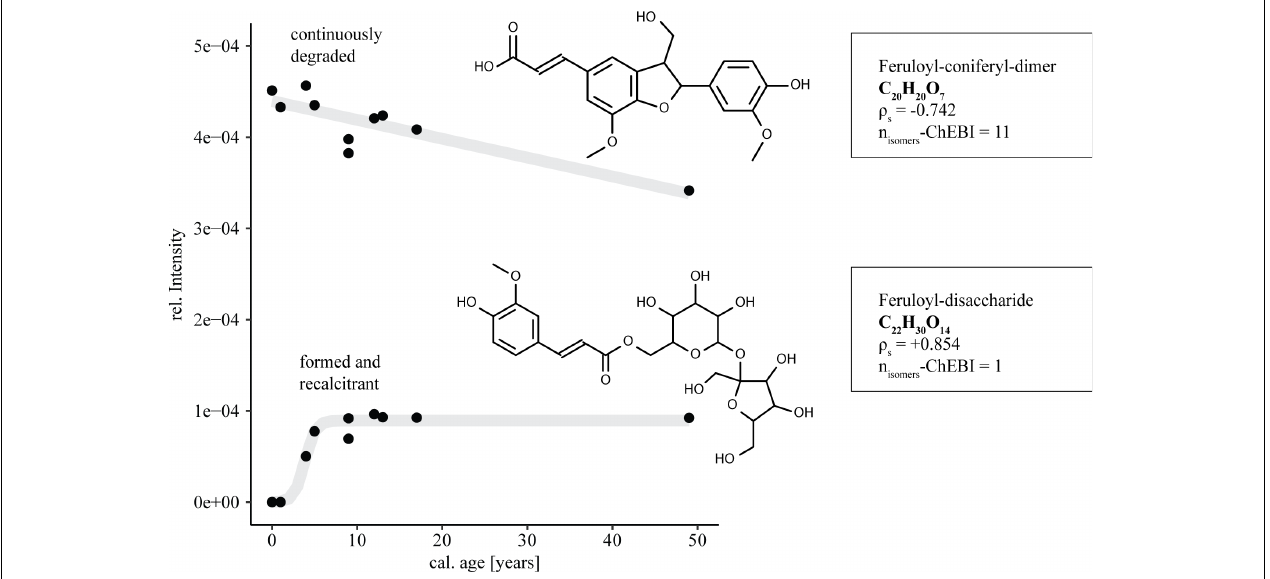
FIGURE 4 | Effect of DOM age on FT-ICR-MS relative intensity distributions of ferulic acid derivatives. Trend lines are given in gray for visual support (top: linear function, bottom: logistic function). ρ s : spearman correlation coefficient; n isomers -ChEBI: number of suggested structural isomers for the respective sum formula.